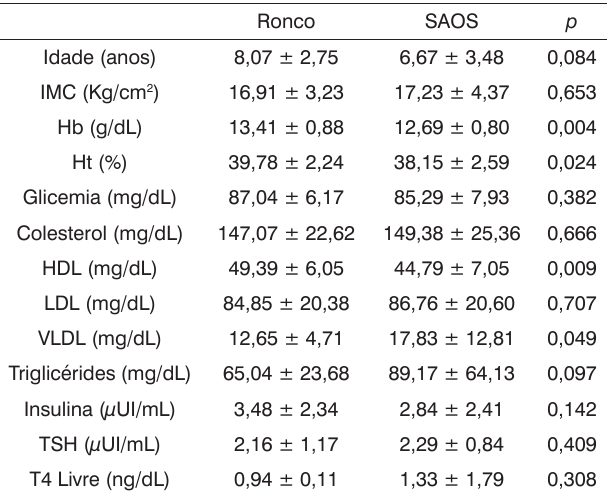
Tabela 1. Análise das variáveis quantitativas nos grupos Ronco e SAOS.